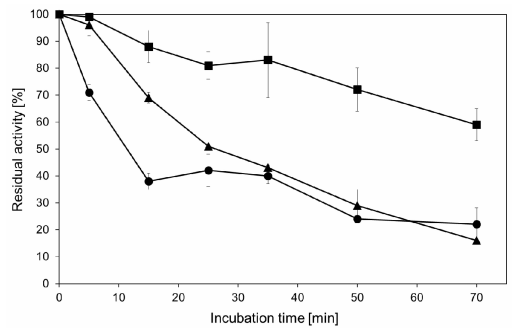
Figure 1. Stability of hyperthermophilic β -glycosidase from Pyrococcus under conventional thermal heating at 85 ˝ C and MWI at 100 and 300 W, respectively. Residual β -galactosidase activity ( p NP- β -Gal) was assayed after incubation in a conventional heating block ( (cid:4) ) or under microwave irradiation at 100 W ( (cid:78) ) or 300 W ( ). Assayed enzyme activity under standard condition was used as a reference (100% corresponds to 17